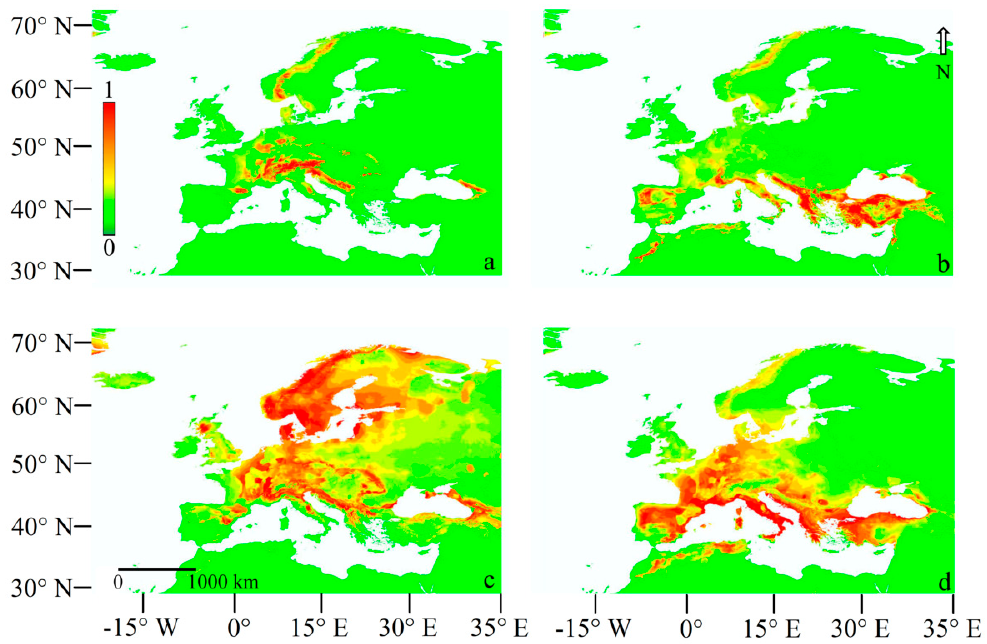
Figure 3. Ecological Niche Models for P. mugo / uncinata ( a ), P. nigra ( b ), P. sylvestris ( c ) and Q. pubescens ( d ) using current scenario. Scales show the probability of presence ranging from 0 to 1.